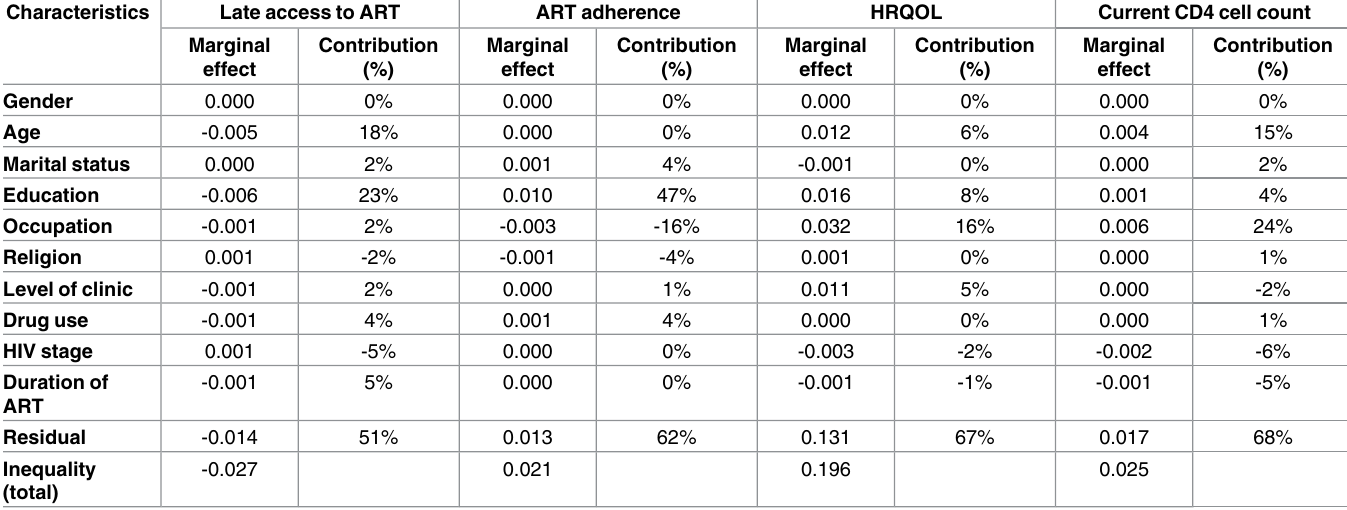
Table 4. Decomposition of SES inequalities in ART access,adherence and outcome treatments.